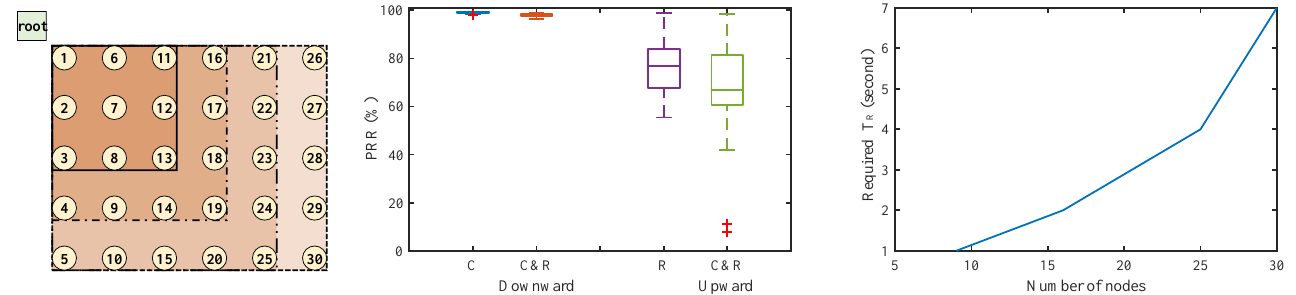
PRR vs. the number of nodes in the network. Figure 1. Grid topology for the preliminary simulation and the result. Figure 1. Grid topology for the preliminary simulation and the